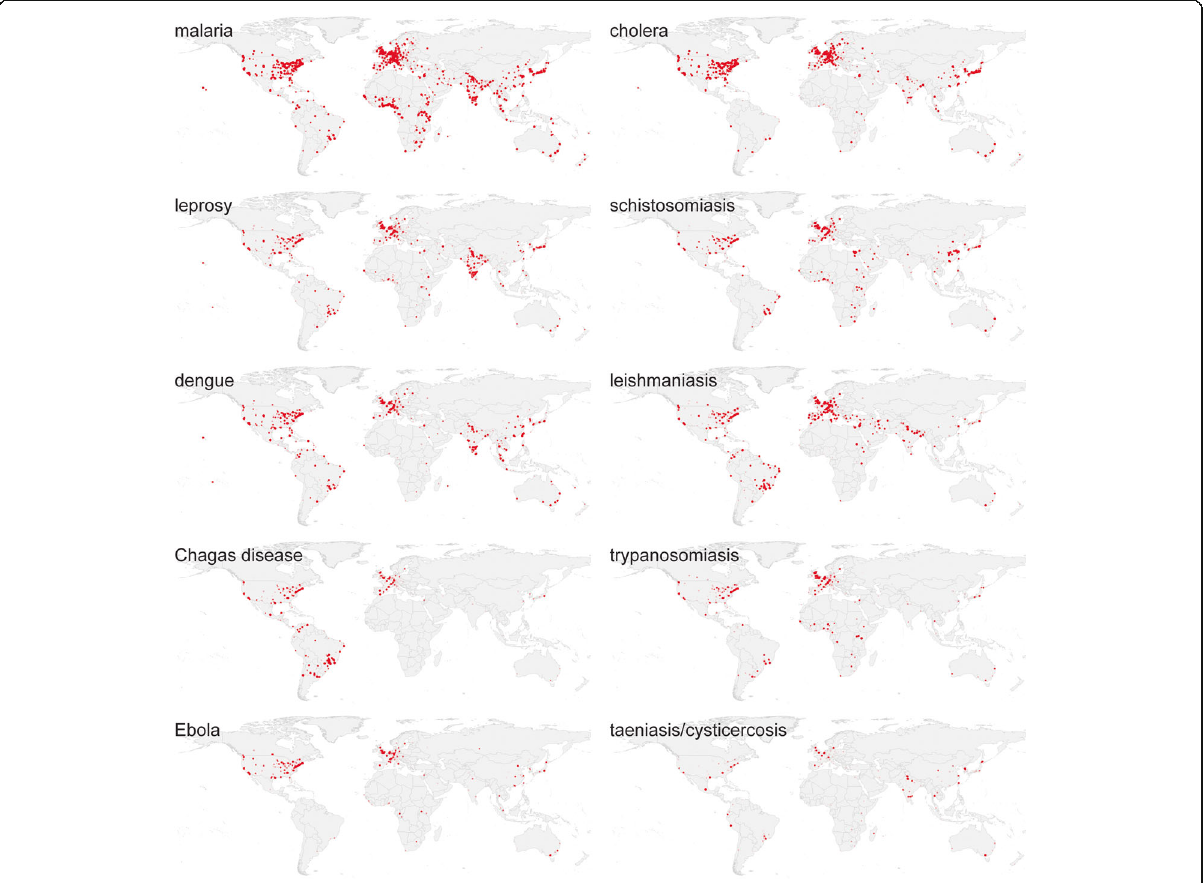
Fig. 5 Tropical diseases research 1813 – 2016. Map of absolute research output on tropical diseases 1813 – 2016 measured by 253,277 publications in Europe PMC and geoparsed by MapAffil (all on the same QGIS linear heatmap scale with radius 1.25 and maximum value 25). Made with Natural Earth. Free vector and raster map data at